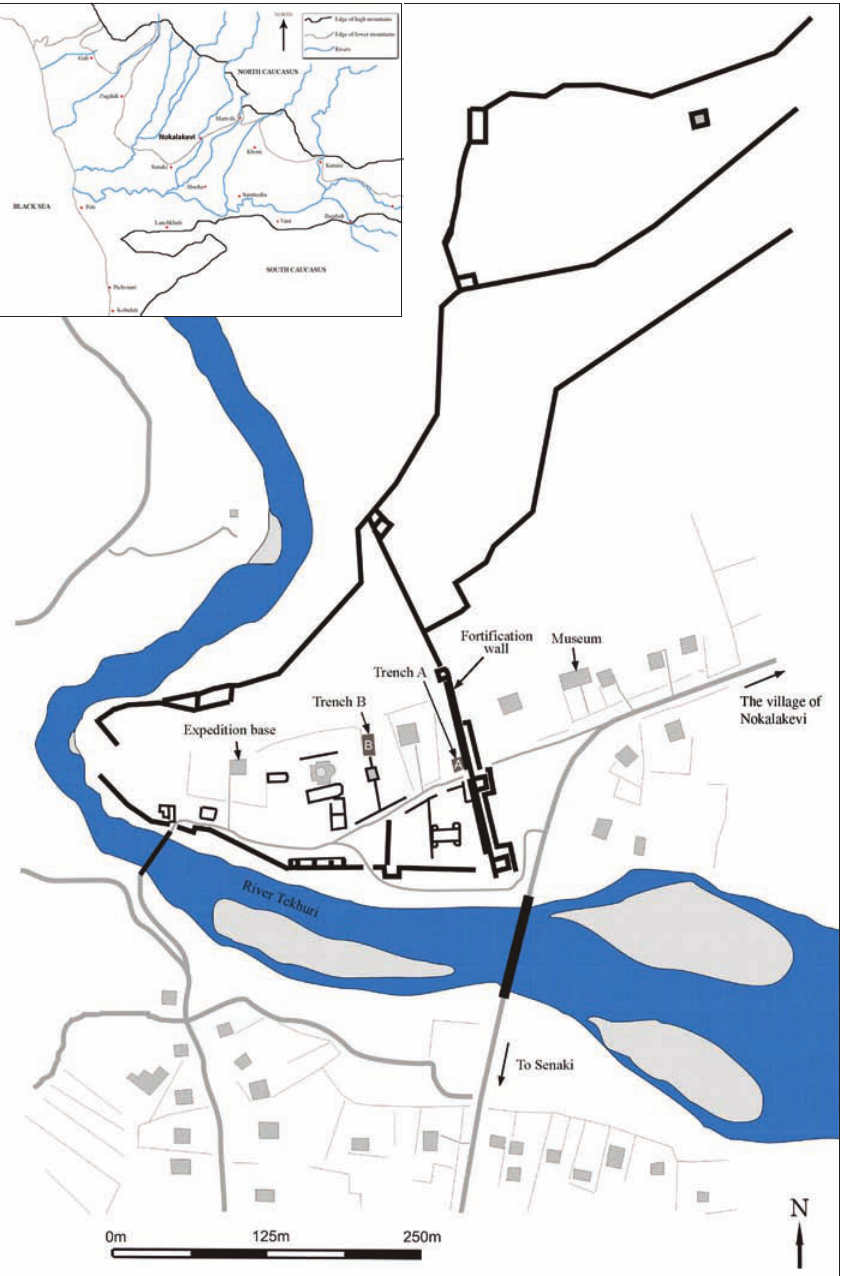
Figure 1 Plan showing the site surroundings and trench locations (map of West Georgia drawn by Benjamin Neil site plan drawn by Dr Paul